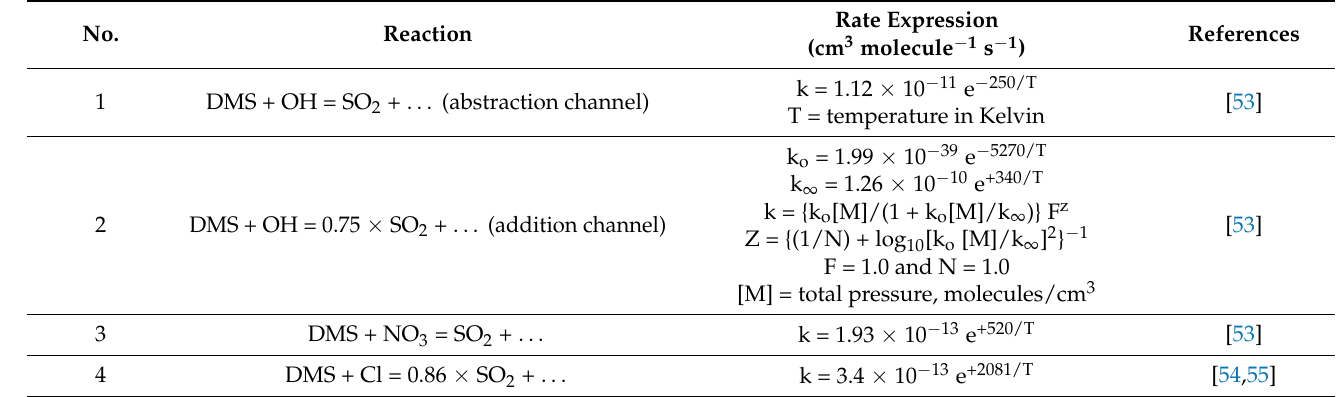
Table 1. Gas-phase chemical reactions for DMS oxidation in